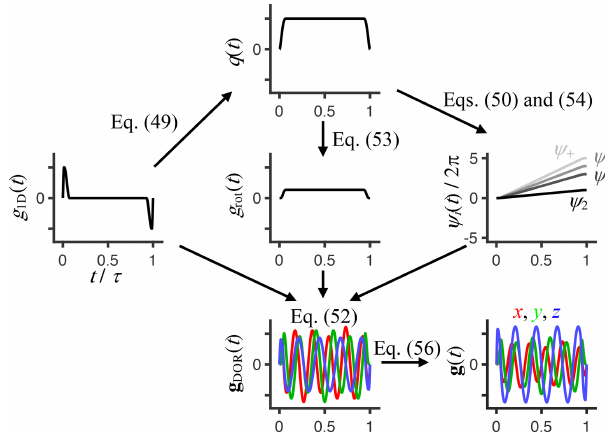
Figure 2. Flowchart for calculating a double-rotation gradient waveform g DOR ( t ) given a 1D dephasing/rephasing waveform g 1D ( t ), rotation axis inclinations ζ 1 and ζ 2 , double-rotation ratio n , and total angle of rotation (cid:49)ψ 2 during the waveform duration τ . The waveform g 1D ( t ), containing dephasing and rephasing pulses with sinusoidal ramps of durations ε up and ε down , gives the time- dependent magnitude of the dephasing vector q ( t ) via Eq. (49), which yields the time-dependent rotation angles ψ i ( t ) via Eqs. (50) and (54) as well as the time-dependent magnitude of the rotating and oscillating gradient g rot ( t ) via Eq. (53). Combining g 1D ( t ), g rot ( t ), and ψ i ( t ) via Eq. (52) gives g DOR ( t ), which, if ζ 1 = 90 ◦ and ζ 2 = − 54 . 7 ◦ , n is an integer above 1, and (cid:49)ψ 2 is a multiple of 360 ◦ , achieves isotropic encoding tensors b where the anisotropy b (cid:49) and asymmetry b η are both equal to zero. Finally, waveforms g ( t ) for any values of b (cid:49) and b η are obtained by scaling of the Cartesian components of g DOR ( t ) according to Eq. (56). The shown exam- ple was generated with the MATLAB code provided in the Sup- plement using ε up = 0 . 015 τ , ε down = 0 . 06 τ , (cid:49)ψ 2 = 360 ◦ , n = 4, b (cid:49) = 0 . 5, and b η = 0 .